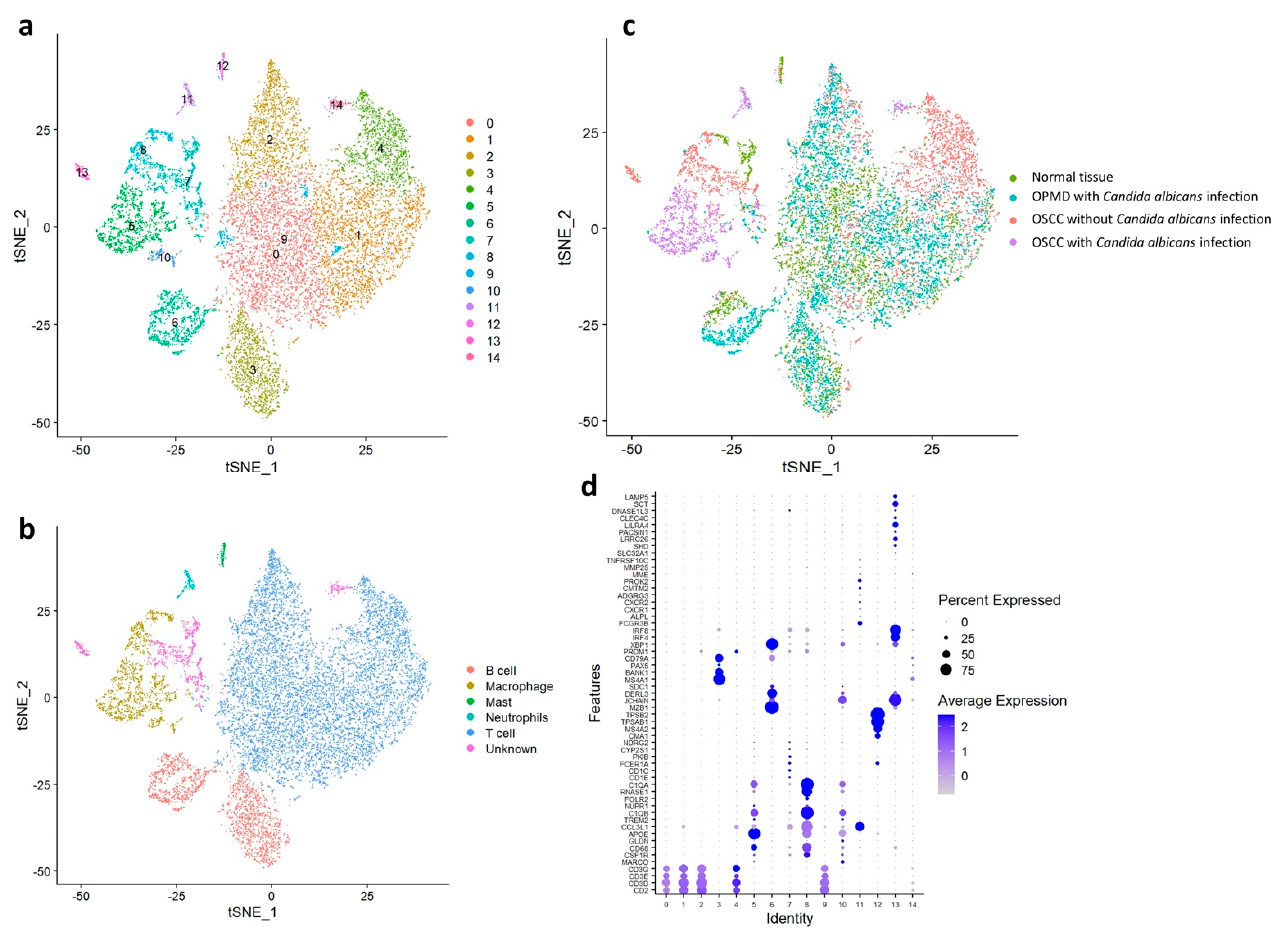
Figure 3. Immune cell distribution in the normal tissue, OPMD lesion with Candida albicans infection, OSCC tissue with C. albicans infection, and OSCC tissue without C. albicans infection. ( a ) Classification of immune cells into 15 subtypes by using the Louvain algorithm. ( b ) Classification of immune cells into B cells, macrophages, mast cells, neutrophils, T cells, and unknown cells. ( c ) Separation of the four major groups. ( d ) Classification of cell types in each cluster by using specific biomarkers.